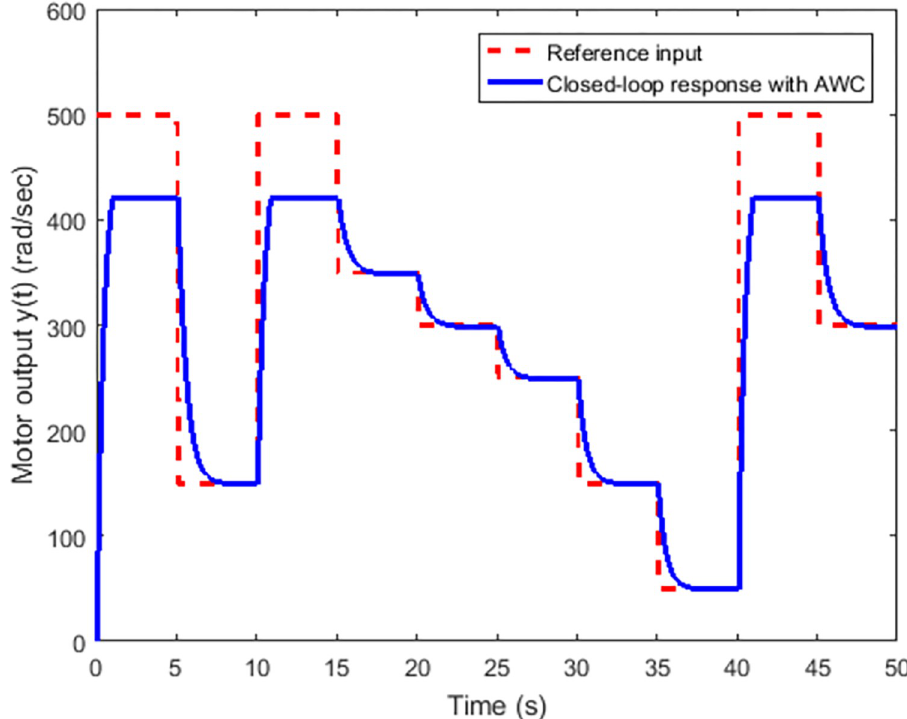
Fig 10. Response with the proposed AWC under sensor